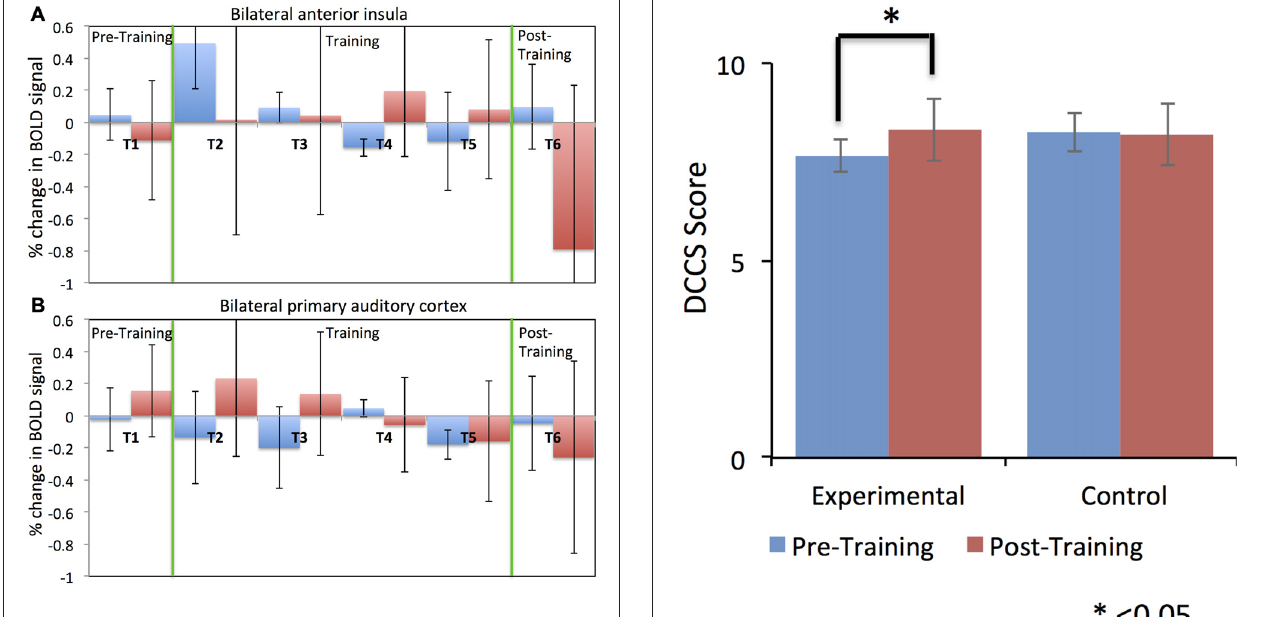
FIGURE 4 | Percentage change in BOLD signal for each run across all six fMRI sessions. Average percentage change in bilateral anterior insula cortex (A) for both the experimental (blue) and the control (red) groups. Average percentage change in bilateral primary auditory cortex (B) for both the experimental (blue) and the control (red) groups. Percentage change in the BOLD signal is calculated by comparing change in the BOLD signal during the regulation block to the previous baseline block. A positive value of the percentage change in BOLD signal indicates up-regulation of BOLD signal.